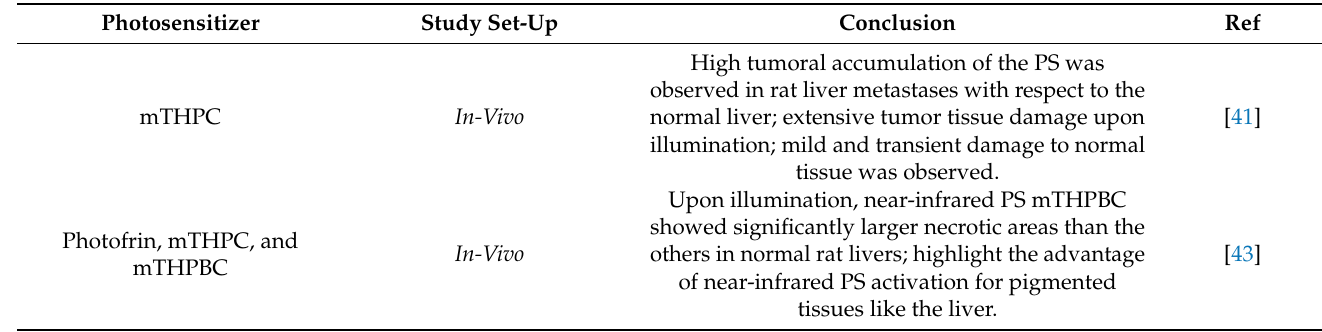
Table 2. List of various photosensitizers tested on Hepatocellular Carcinoma, hepatoma or healthy liver for Photodynamic Diagnosis, or Photodynamic Therapy or both. PS: Photosensitizer; PDT: Photodynamic Therapy; HCC: Hepatocellular Carcinoma; mTHPC: meta-tetra (hydroxyphenyl) chlorin; mTHPBC: 5,10,15,20-tetrakis (m-hydroxyphenyl) bacteriochlorin; 5-ALA: 5-Aminolevulinic Acid; ICG: Indocyanine